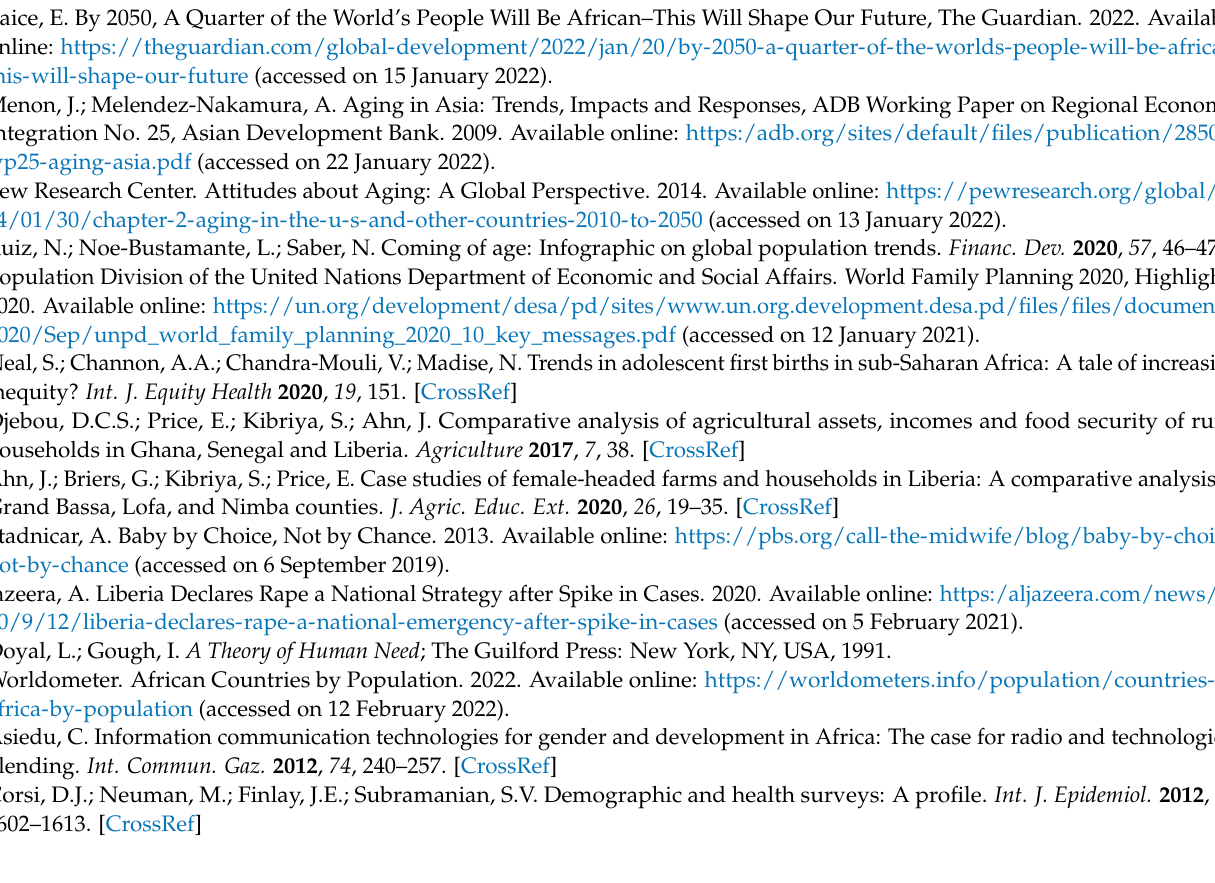
Figure S4: Initial imbalance in covariates (Stata output); Figure S5: Automated CEM summary (Stata output); Figure S6: K-to-K matching summary (Stata output); Figure S7: SATT estimate/univariate regression results (Stata output); Figure S8: Multiple linear regression results (Stata